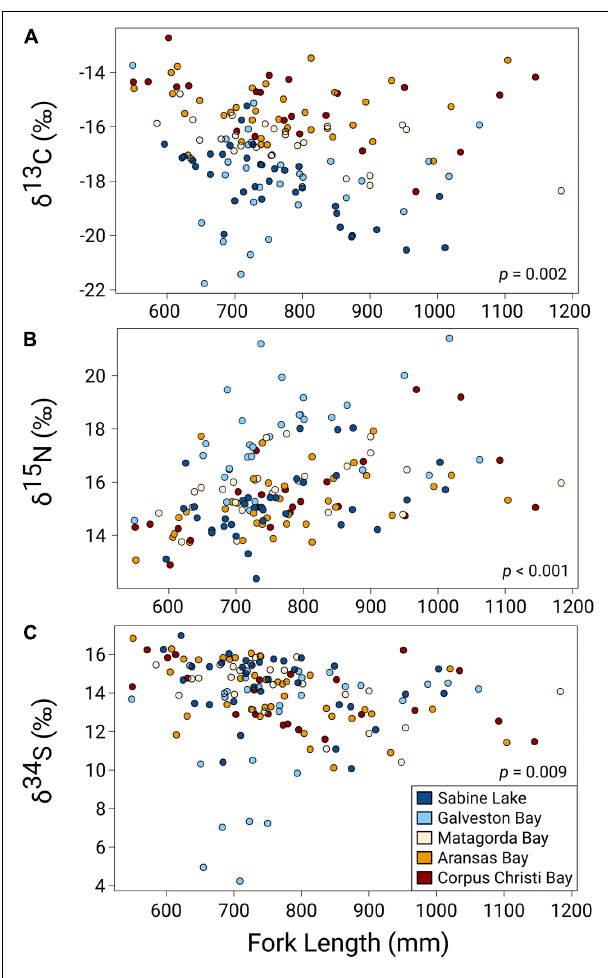
FIGURE 3 | Regressions of stable isotope (A) δ 13 C, (B) δ 15 N, (C) δ 34 S values against size fork length (FL) of juvenile bull sharks from estuaries in the nwGoM. P -values denote significance of FL as main effect in generalized least squares models of δ Y ∼ FL + Year + Season + Estuary.